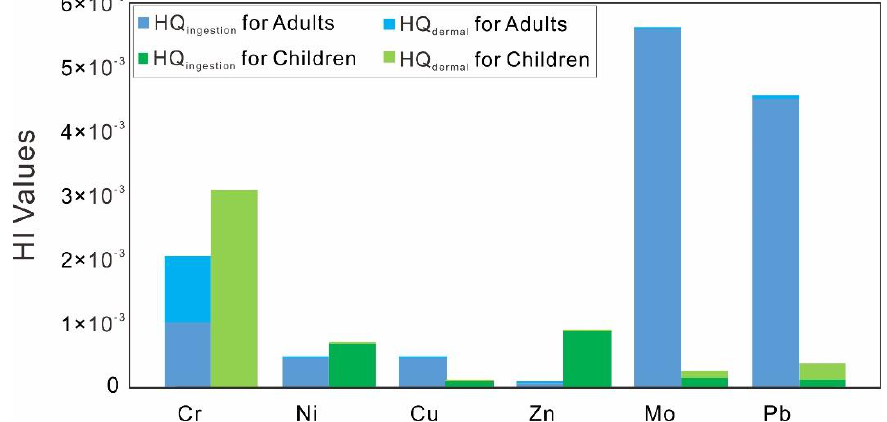
Figure 5. The hazard index values for the water samples in the Lancangjiang River.